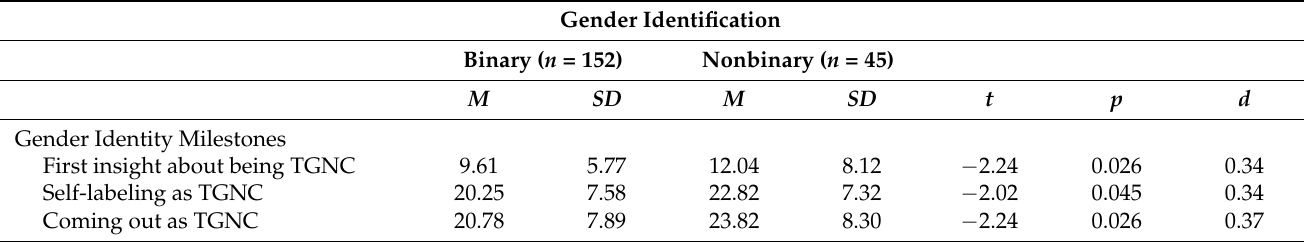
Table 3. Means comparisons of gender identity milestones based on gender identification.